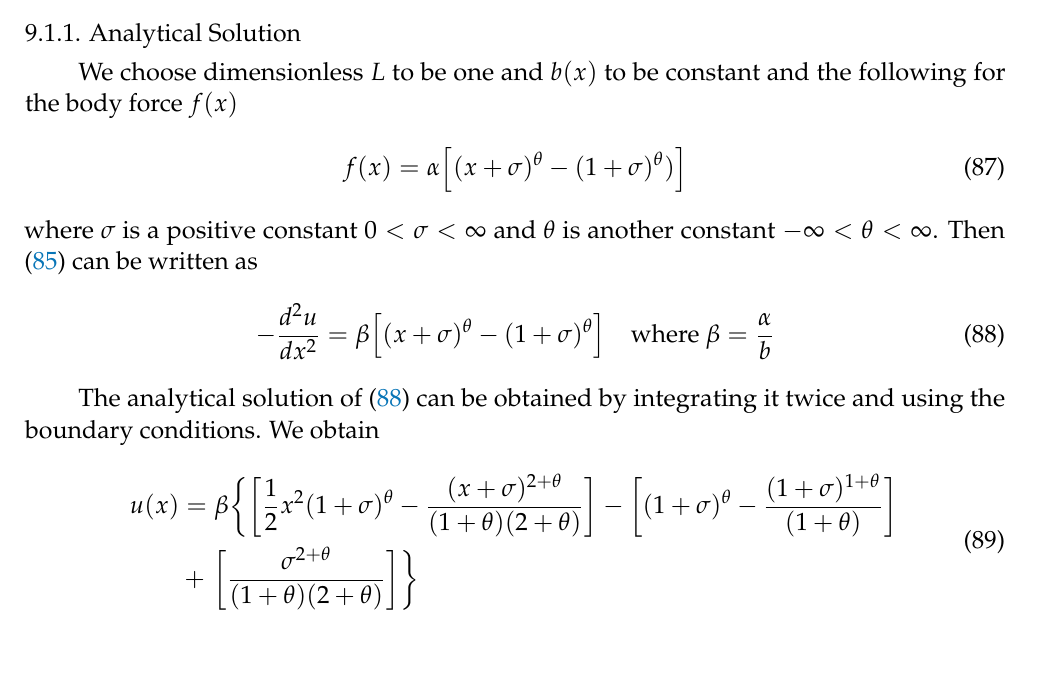
Figure 10. Axial deformation of a rod: schematic and